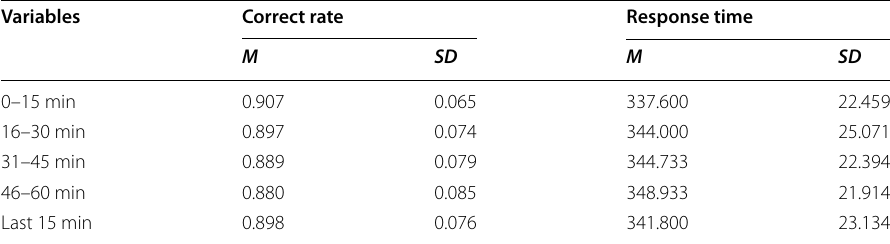
Table 1 Correct rate and correct response time for different time periods Variables Correct